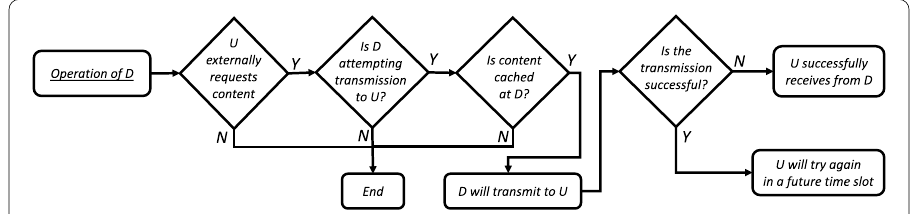
Fig. 4 Operation of D when user U requests a file f from external